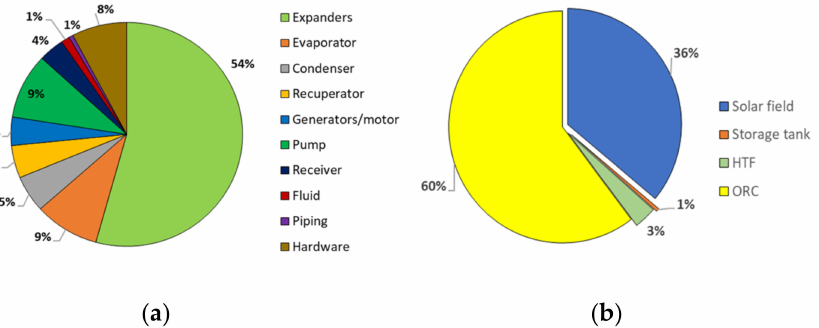
Figure 8. ( a ) Cost distribution of ORC components; ( b ) Cost distribution of sub-systems (results refer to the case of Athens–PTC–Cyclopentane for minimum LCoE (Table 11).